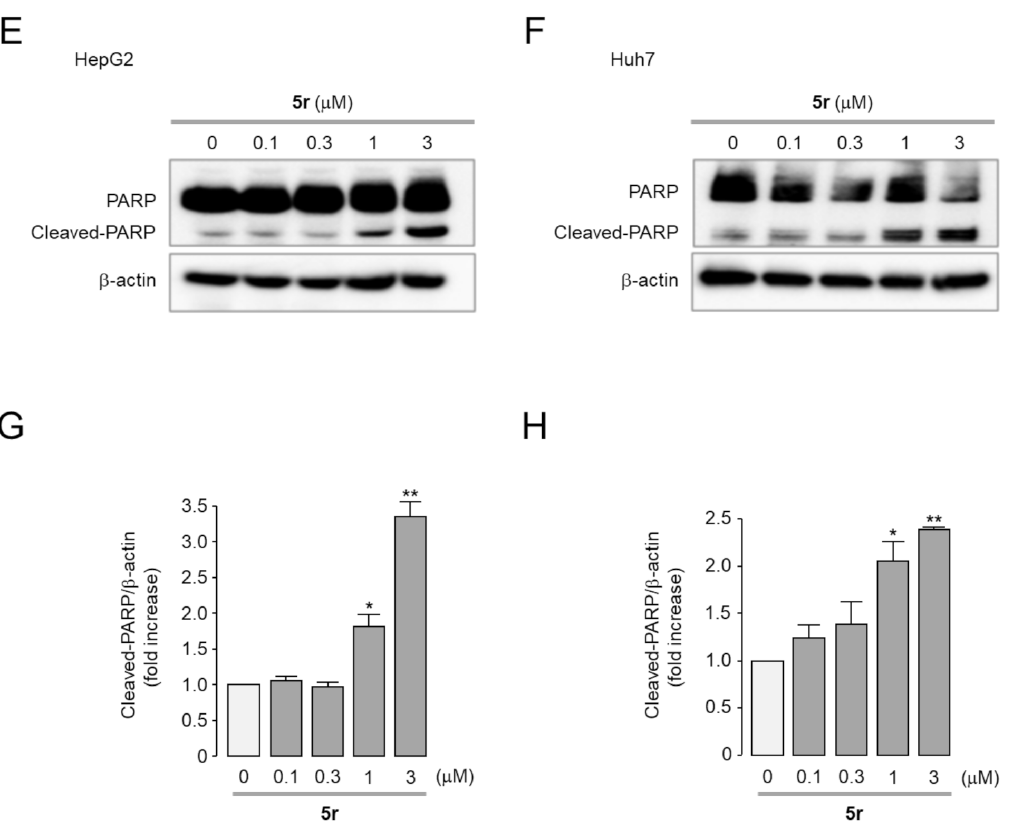
Figure 4. Effect of 5r on activity of caspase-3 and cleavage of PARP in HepG2 and Huh7 cells. ( A , B ) HepG2 and Huh7 cells were incubated with 3 µ M 5r for 24 h and then incubated with 1 µ M caspase-3 substrate (green) and 1 µ M Hoechst 33,342 (blue) for 20 min before image acquisition. ( C , D ) Cells were cultured with 5r at the indicated concentrations for 24 h and then 1 µ M caspase-3 substrate was treated for 20 min. Caspase-3 was inhibited by 20 µ M Ac-DEVD-CHO (mean ± S.D., n = 3). ( E , F ) Cells were cultured with 5r at the indicated concentrations for 24 h, and expression level of PARP, cleaved-PARP and β -actin were measured by Western blot analysis. ( G , H ) Cleaved PARP protein intensities were normalized to β -actin (mean ± S.E., n = 3). * p < 0.05, ** p < 0.01, *** p < 0.001.